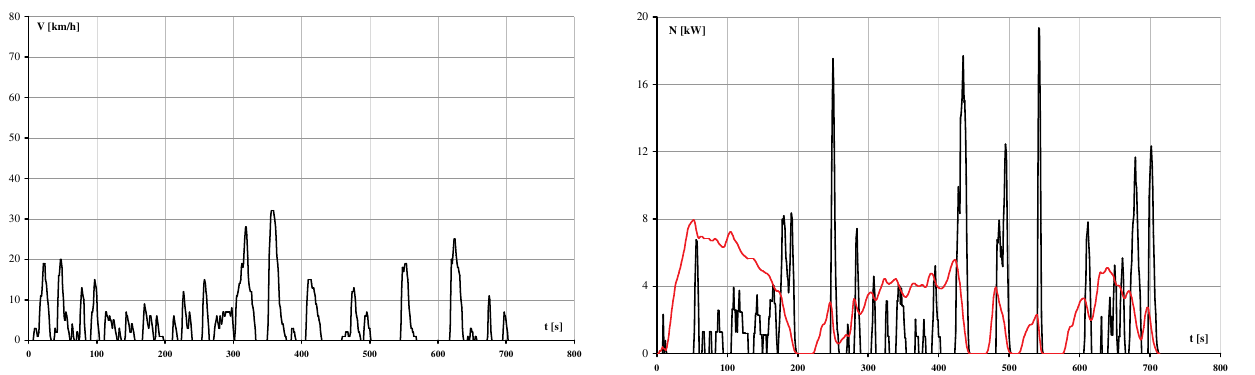
Fig. 4. Kinetic power variation (black color) and resistance power (red color) of the movement at the maximum traffic intensity